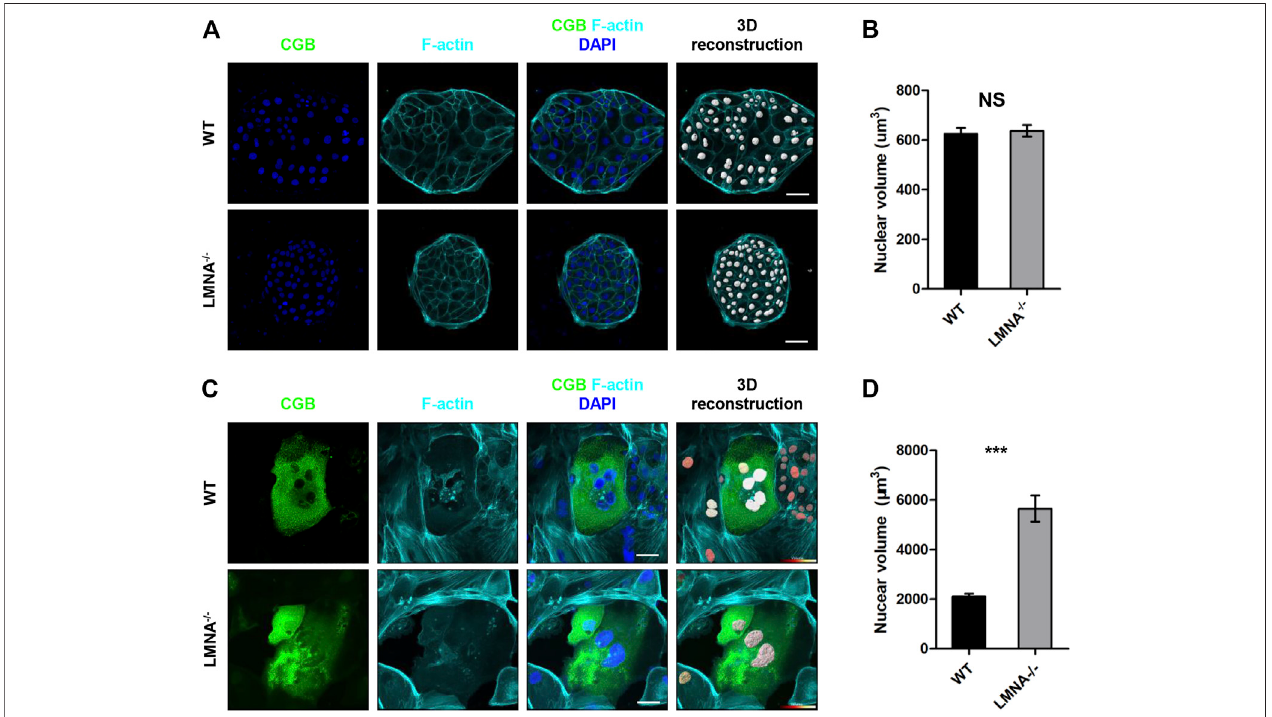
FIGURE6| LossofLMNApromotesnuclearenlargementduringsyncytialization. (A) ImmunostainingofWTandLMNA − / − hTSCsforF-actinandCGB.DAPI,blue, DNA. Scale bars, 50 μ m. The nuclei were 3D reconstructed. (B) Quanti fi cation of nuclear volume in WT and LMNA − / − hTSCs. n = 10 fi elds of view, three experiments. Dataareshownasmean±s.e.m.Unpairedtwo-tailedStudent ’ st-test,NS,notsigni fi cant. (C) ImmunostainingofWTandLMNA − / − STBforCGBandF-actin.DAPI,blue, DNA. Scale bars, 50 μ m. The nuclei were 3D reconstructed. Color key from red to white indicated nuclear volume levels from low to high. (D) Quanti fi cation of nuclear volume in WT and LMNA − / − STB. n = 10 fi elds of view, three experiments. Data are shown as mean ± s.e.m. Unpaired two-tailed Student ’ s t-test, *** p < 0.001.